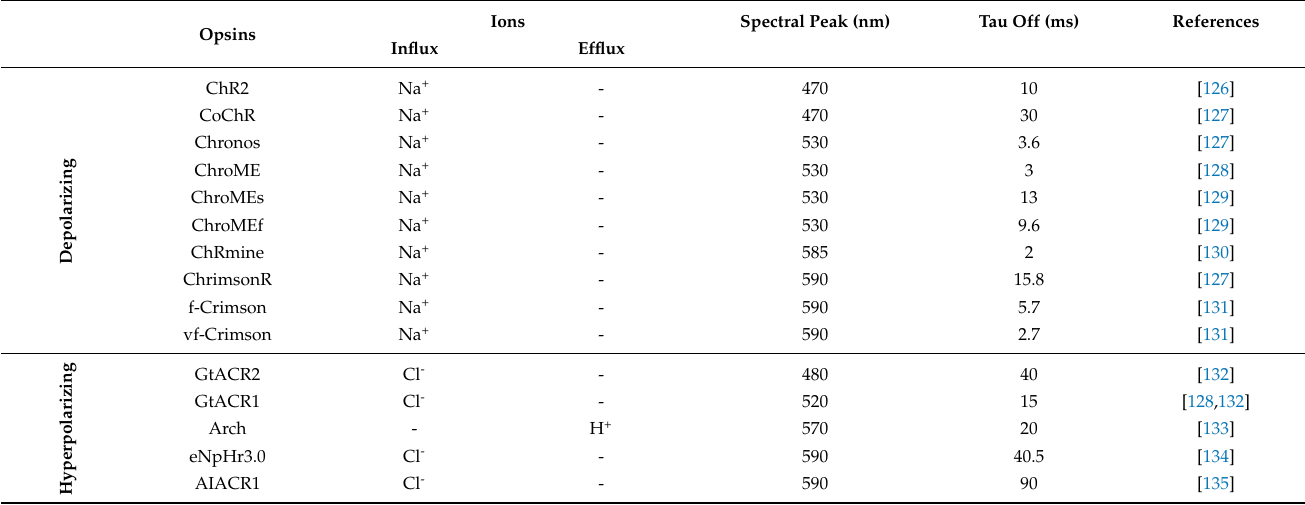
Table 2. Principal depolarizing and hyperpolarizing opsins. For each element, ion specificity, spectral peak and decay time (tau-off) are reported. The values have been obtained from the